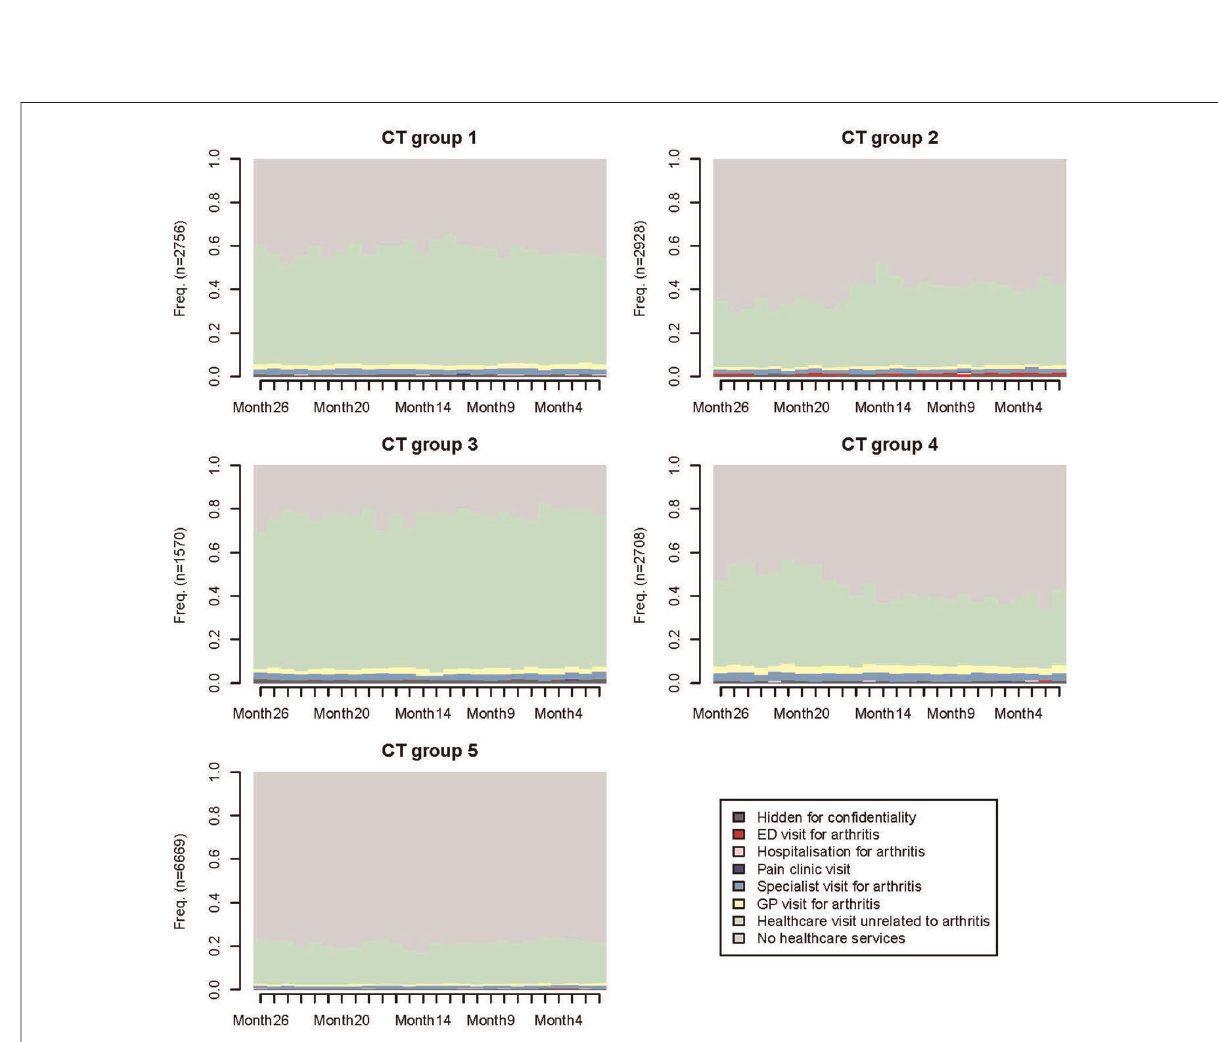
FIGURE 3 Chronograms re fl ecting patterns of health care visits over time for each CareT